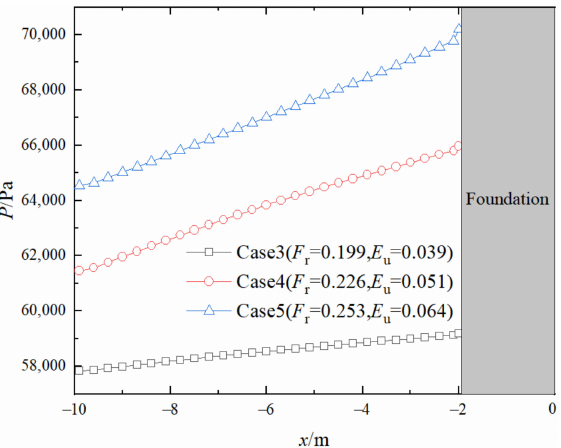
Figure 24. Sketch of adverse pressure gradient at upstream USAF